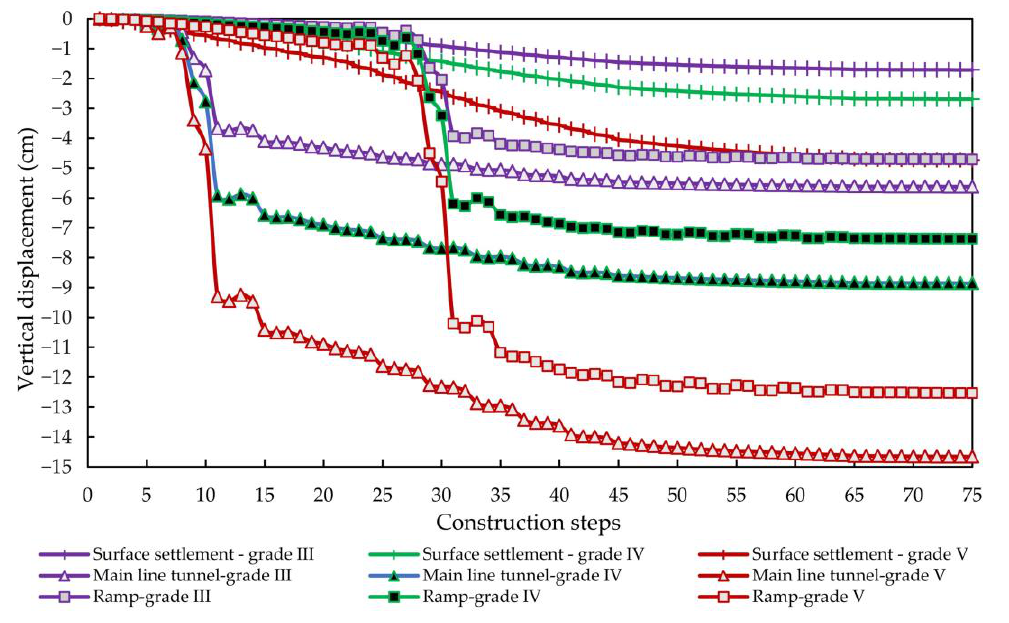
Figure 12. Vertical displacement curves of the ground and vault with different grades of the sur- rounding rock. Table 4. Vertical displacement under various lithologic